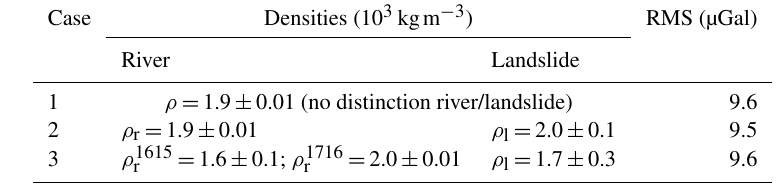
Table 6. Densities obtained for each inversion case with their SD and the root mean square of the residuals V .